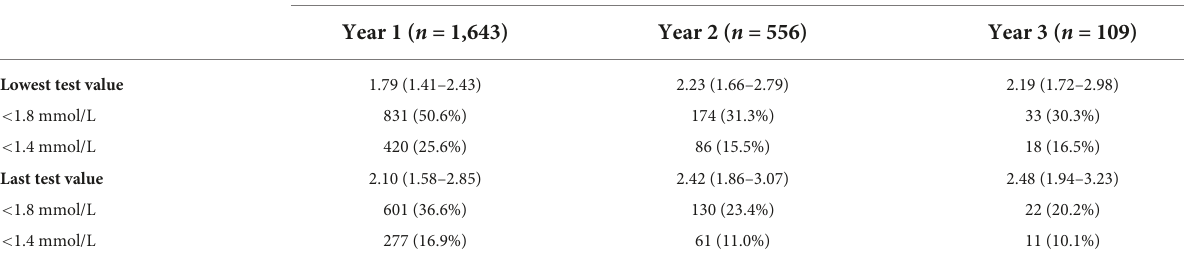
TABLE 2 Lipid values and target achievement rates by years since statin plus ezetimibe. LDL-C values and